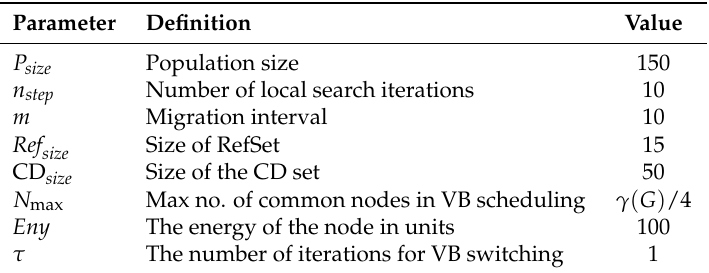
Table 2. Parameter